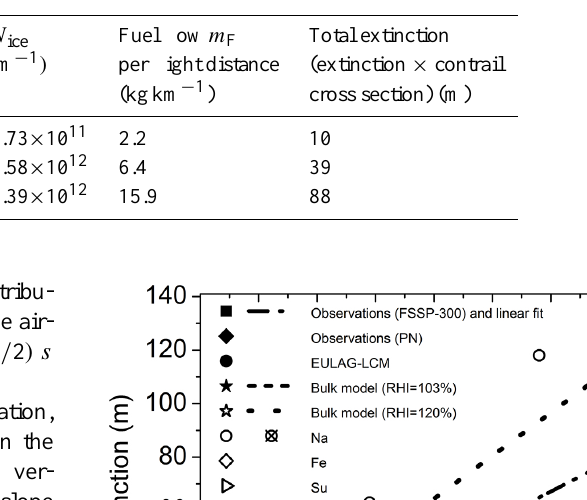
Table 6. Contrail properties, total extinction and fuel consumption per unit flight path for 3 different aircraft.